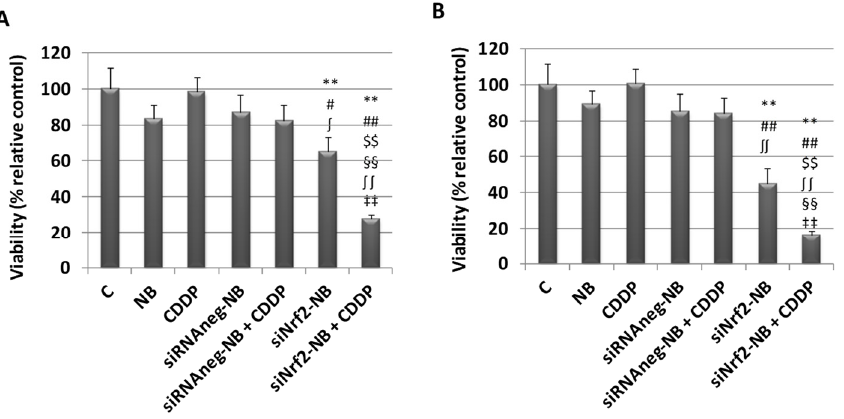
Figure 5. Viability was determined by the MTT assay at 24 h ( A ) and 48 h ( B ) in M14 untreated cells (C, control) or treated with blank NB, 1 µg/mL CDDP, and 0.08 µM siRNAneg-NB or siRNAneg- NB in combination with CDDP (siRNAneg-NB+CDDP) and 0.08 µM siNrf2-NB or siNrf2-NB in combination with CDDP (siNrf2-NB+CDDP). Results are expressed as the percent of the relative control values and are the mean ± standard deviation of three separate experiments performed in triplicate. ** p ≤ 0.01 vs. C; # p ≤ 0.05 and ## p ≤ 0.01 vs. NB; $$ p ≤ 0.01 vs. CDDP; ʃ p ≤ 0.05 and ʃʃ p ≤ 0.01 vs. siRNAneg-NB; §§ p ≤ 0.01 vs. siNrf2-NB; and ‡‡ p ≤ 0.01 vs. siRNAneg-NB + CDDP.